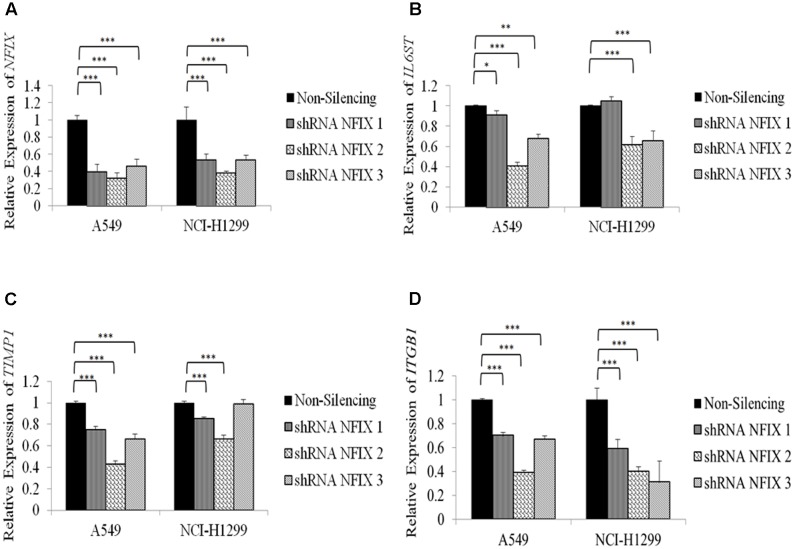
A549 and NCI-H1299 cell lines transfected for 48 h with NFIX shRNAs had reduced NFIX expression. (A) Relative expression of NFIX after 48 h NFIX shRNAs transfection. (B) Transfection of NFIX shRNAs reduced IL6ST gene expression in both cell lines. (C) Transfection with NFIX_2shRNA showed the most significant reduction of TIMP1gene expression. (D) Transfection of NFIX shRNAs significantly reduced ITGB1 gene expression in both cell lines. ∗p < 0.01;∗∗ 0.01 < p < 0.05; ∗∗∗p < 0.05.